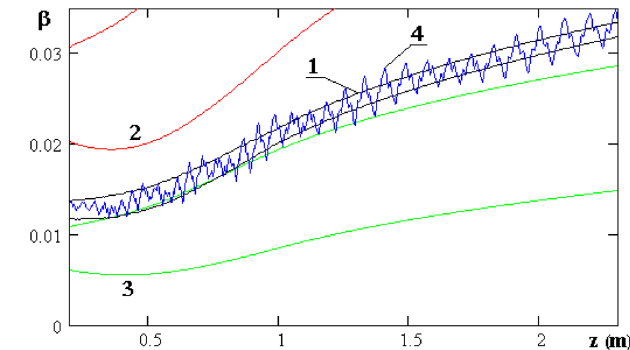
FIG. 4. (Color) The effect of the first rf field harmonic to the beam dynamics. The variation of the vertical size of the separa- trix of the combined wave (curve 1), zero (curve 2), and first (curve 3) rf field harmonics and the longitudinal velocity of the particles with a rapid oscillating component (curve 4) are shown. longitudinal velocity of particles with rapid oscillating components (curve 4). Even if the separatrices do not overlap, the phase trajectory of the particle with a large amplitude of the fast oscillation may be captured into the